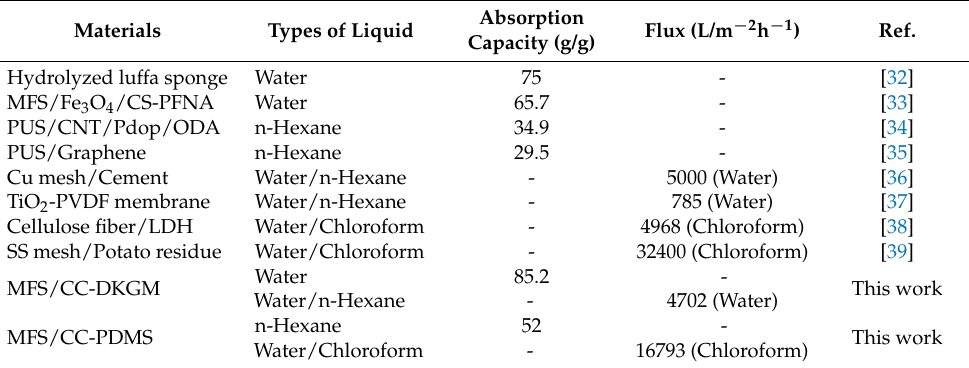
Table 1. Performance comparison of different oil/water